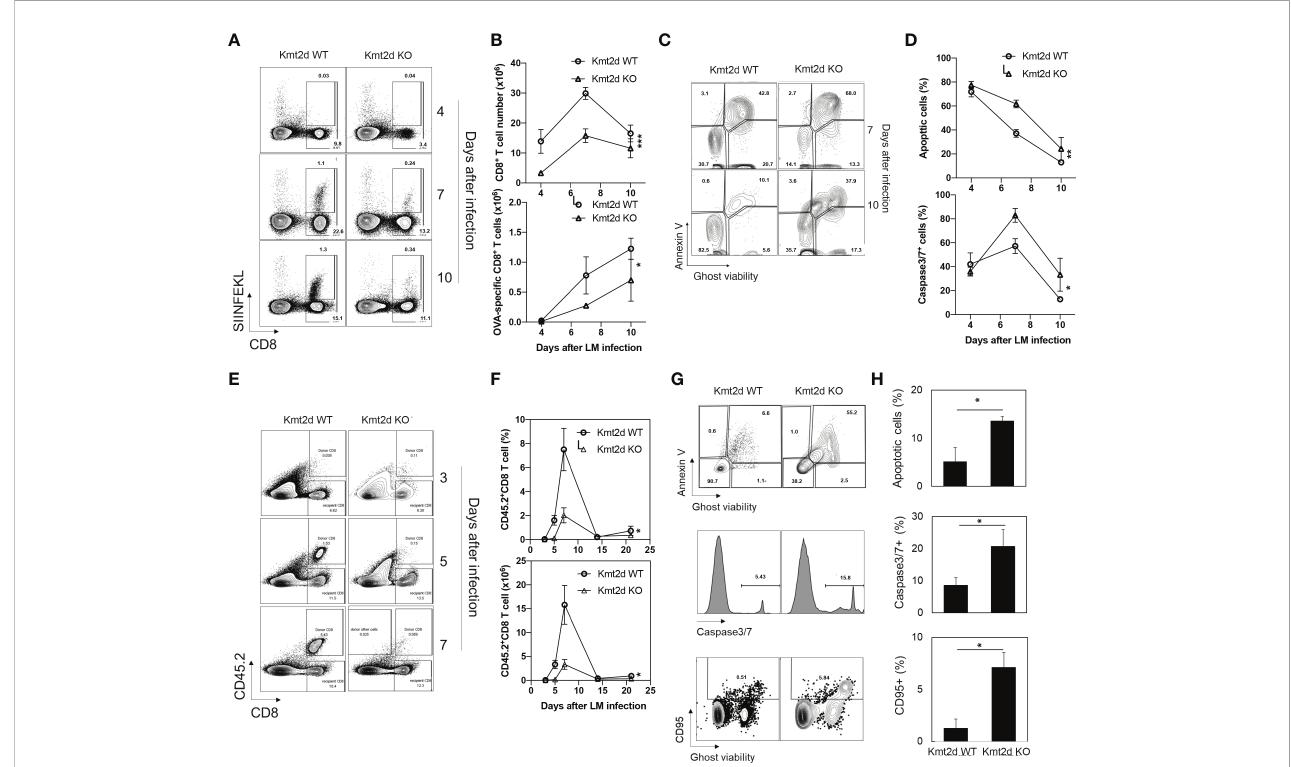
FIGURE 6 Reduced response of antigen-speci fi c CD8 + T cells of Kmt2d KO mice to Listeria infection. (A) Representative plot of OVA-speci fi c CD8 + T cells after LM-OVA infection. Kmt2d WT or Kmt2d KO mice were infected with 5x10 4 cfu of LM-OVA and followed for 10 days. Number of OVA-speci fi c CD8 + T cells from spleen were analyzed at indicated days post infection. SIINFEKL (OVA 257-264 )-dextramer was used for detection of OVA-speci fi c CD8 + T cells. (N=3-4 each time point). (B) Apoptosis was analyzed using annexin V and Ghost viability dye at indicated days. (C) Representative plot of apoptosis analysis of OVA-speci fi c CD8 + T cells in LM-OVA infected Kmt2d WT or Kmt2d KO mice at indicated days. (D) AnnexinV + /Ghost viability dye + apoptotic cell (up) and Caspase3/7 activity positive cell (down) ratio in antigen speci fi c cells (CD8 + , SIINFEKL + , N=3-4 each time point). (E-H) Naïve CD8 + T cells from Kmt2d WT-OT-1 or Kmt2d KO-OT-1 mice were transferred to congenic mice and infected with LM-OVA. As OT-1 mouse has only OVA-speci fi c CD8 + T cells, transferred cells were identi fi ed with CD45.2 and CD8. N=3-4 each day. (E) Representative plot of donor cells in congenic mice after LM- OVA infection at indicated time points. (F) Donor naïve CD8 + OT-1 T cells after LM-OVA infection. LM-OVA was injected 1day after donor cell transfer. (G) Representative plot of apoptosis analysis. AnnexinV/Ghost viability dye (top), active caspase3/7 (middle), and CD95 (bottom) expression in donor cells. (H) Average percentage of apoptotic cells, caspase active cells, and CD95 + cells in donor cells. The time course differences were calculated by two-way Anova test *, p<0.05, **, p<0.01 and ***, p<0.001. Paired comparison was calculated by Student ’ s t-test. *,